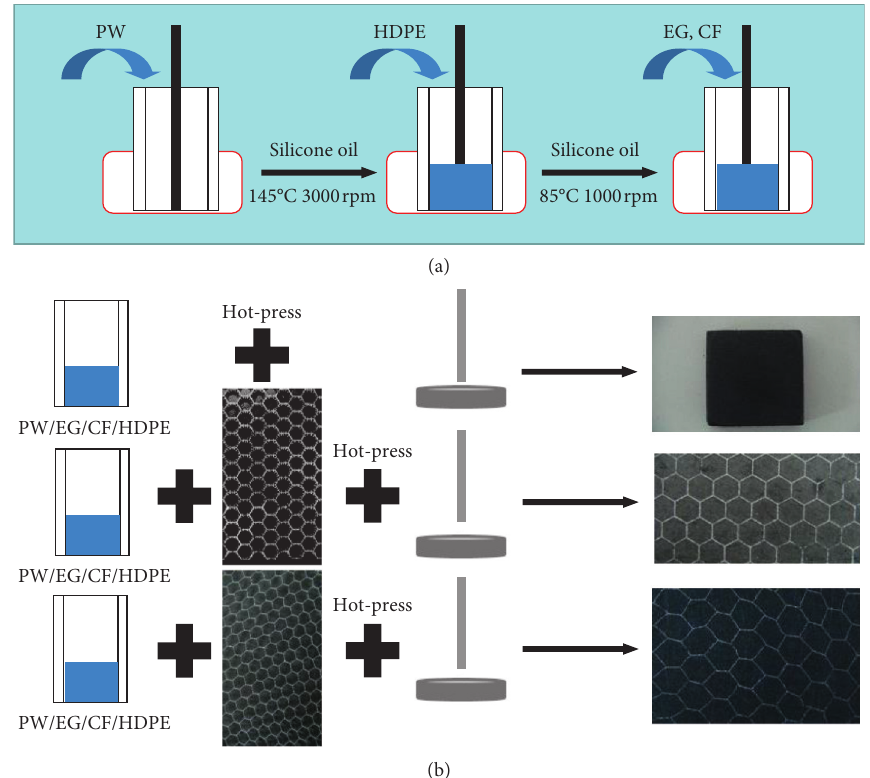
Figure 2: Schematic of the PW/EG/CF/HDPE and PW/EG/CF/HDPE/3D Al-Hc composite samples that were formed by melt mixing. (a) Schematic diagram of the preparation process of the PW/EG/CF/HDPE. (b) Preparation of the CPCM